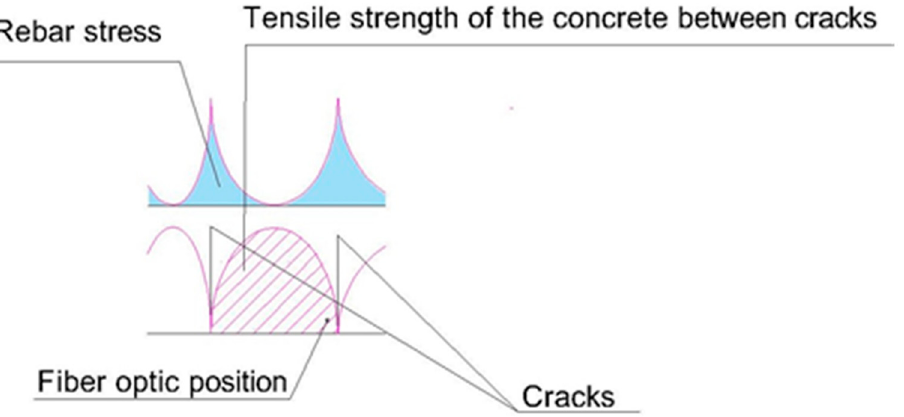
Figure 24. Determining deformation of the steel between cracks on 300 × 500 mm beam.